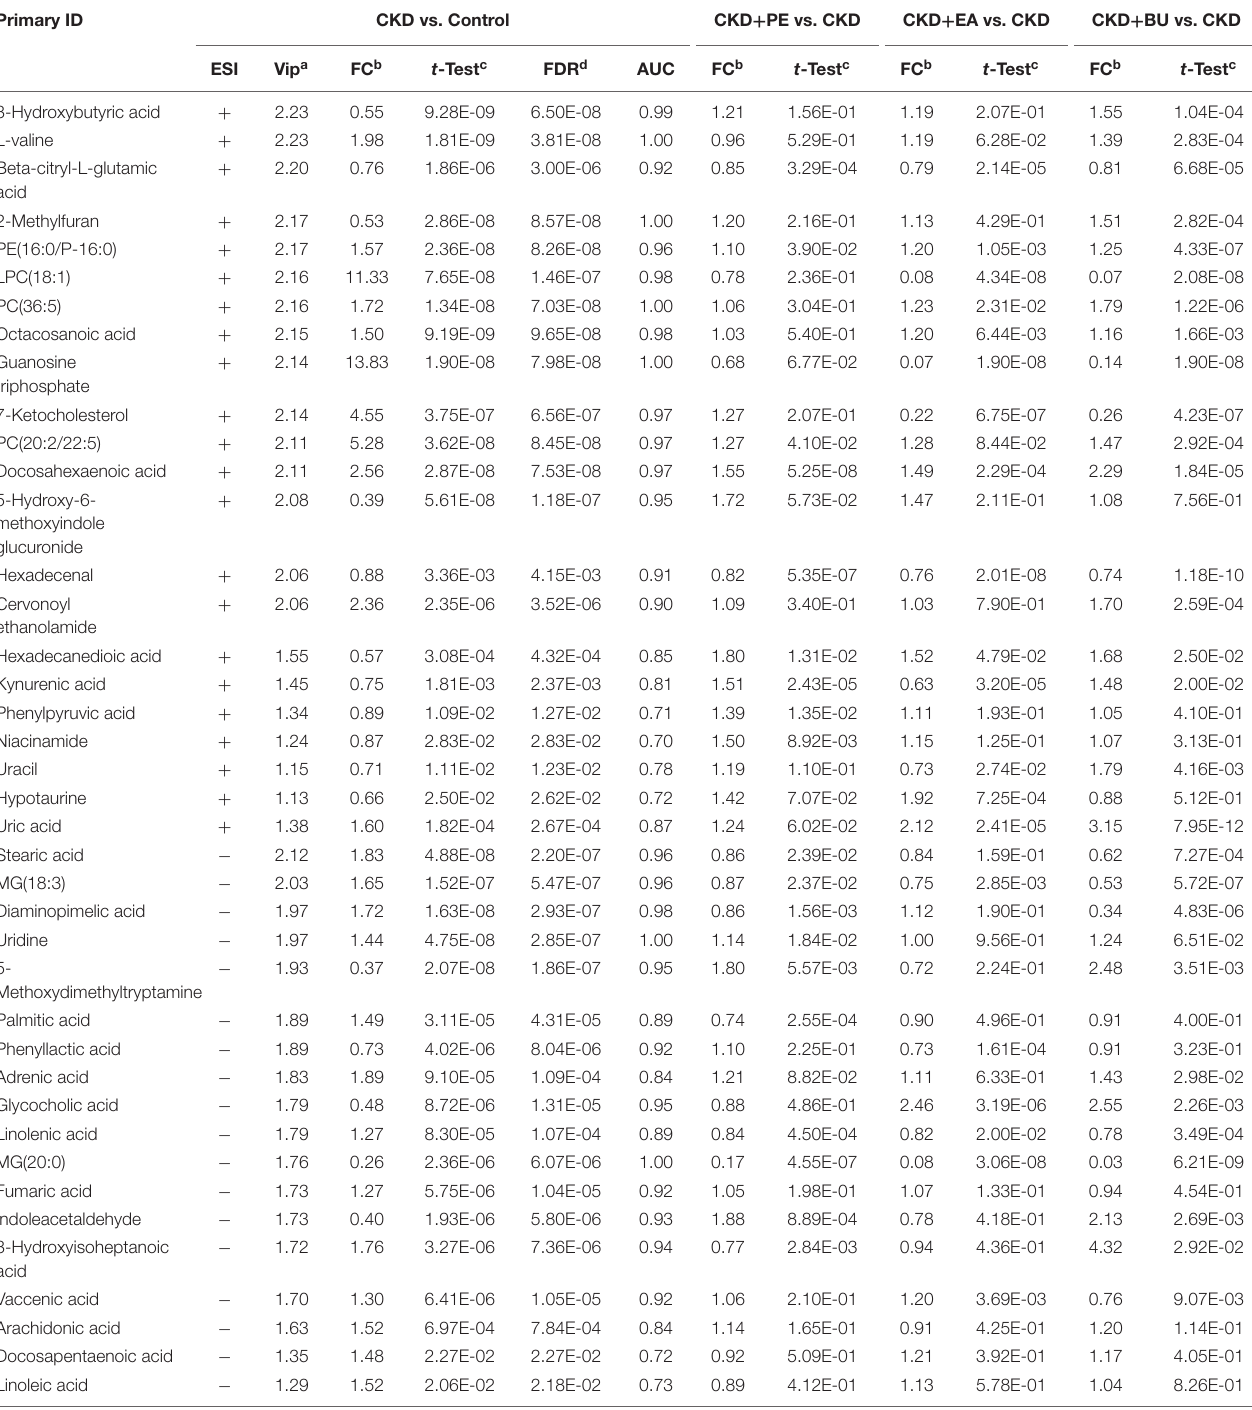
TABLE 1 | Differential metabolites from different groups at weeks